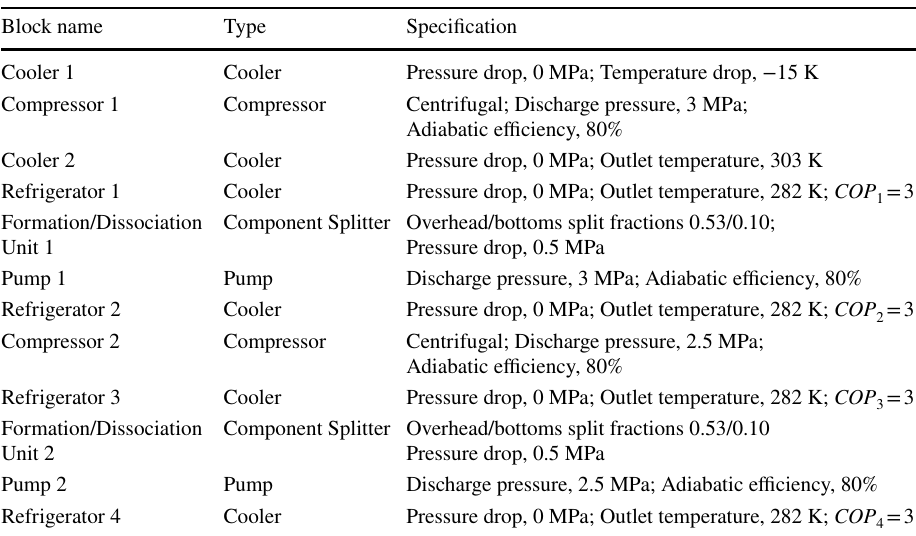
Table 2 Block types and parameters specification